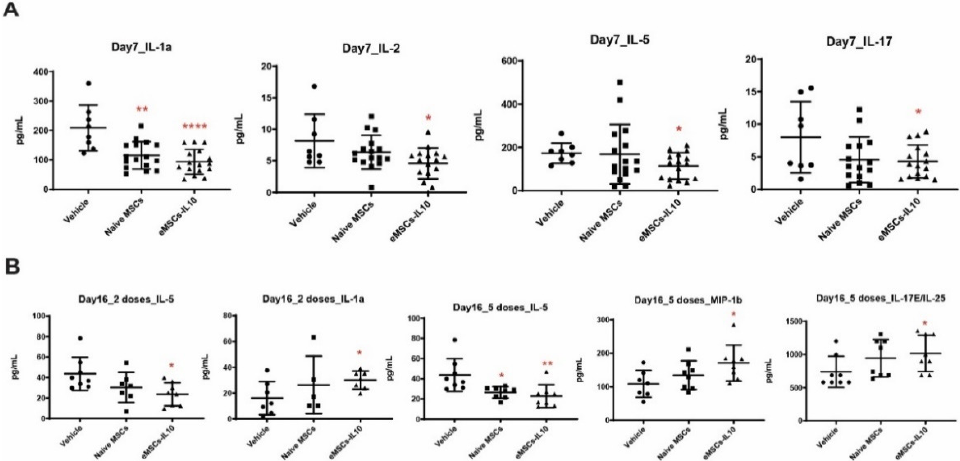
Figure 6. Engineered MSCs-IL10 reduced pro-inflammatory cytokine levels in serum. ( A ) eMSCs-IL10 2-dose treatment regimen significantly reduced serum IL1 α , IL-2, IL-5, and IL-17 levels compared to the vehicle group on Day 7. ( B ) Serum IL-5 concentration remained at a low level on Day 16 in the eMSCs-IL10 2-dose regimen group, the eMSCs-IL10 5-dose group, and the naïve MSCs 5-dose group. In contrast, IL-1 α level in the eMSC-IL10 2-dose group increased compared to the vehicle group on Day 16, and so did IL-17E and MIP-1 β levels in the eMSCs-IL10 5-dose group. Data presented as mean ± SD, * p < 0.05, ** p < 0.01, and **** p < 0.0001.